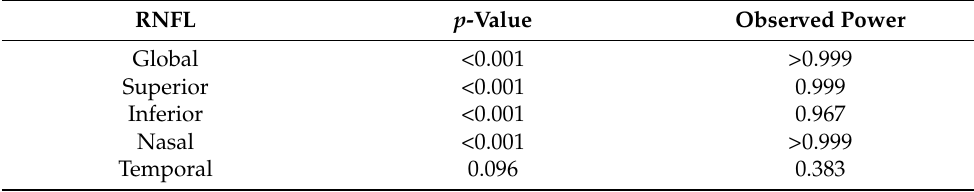
Table 1. p -Values and observed power for global and sectorial RNFL thickness